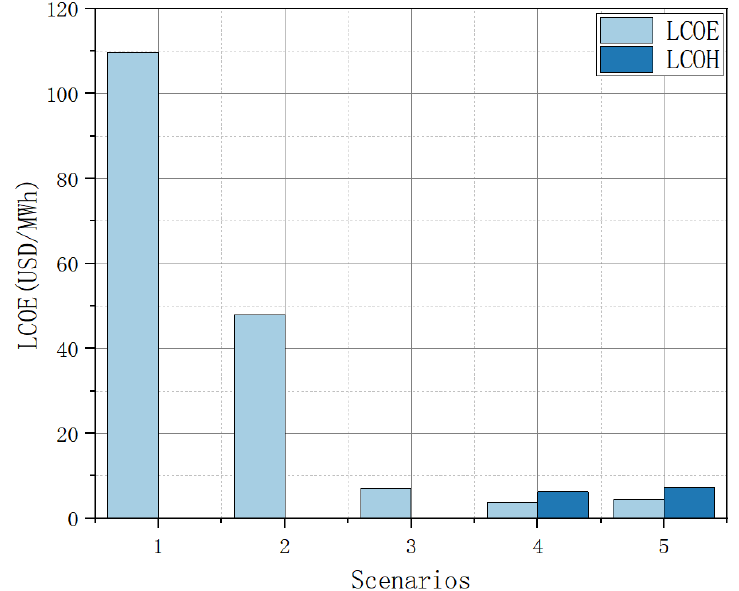
Figure 11. LCOE and LCOH of five scenarios .